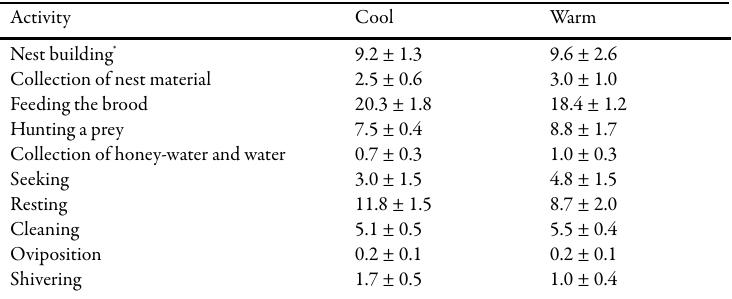
Table 2. Mean time (min) of relative activities in an hour of observation. Behavioral repertoire of the foundresses under cool ( N =5) and warm ( N =5) conditions was given. Activity